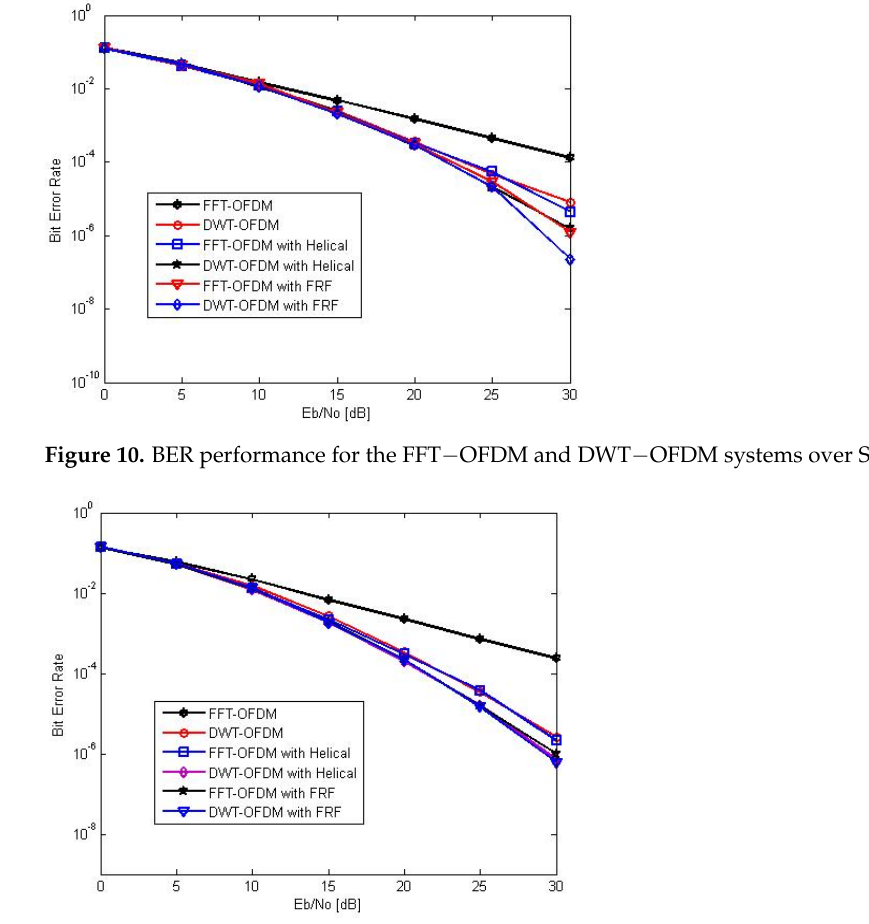
Appl. Sci. 2022 , 12 , x FOR PEER REVIEW 15 of 18 − OFDM and DWT − OFDM systems over SUI-3 channel. Figure 11. BER performance for the FFT − OFDM and DWT − OFDM systems over SUI-3 channel. Figure 11. BER performance for the FFT Figure 11. BER performance for the FFT − OFDM and DWT − OFDM systems over SUI-3 channel.